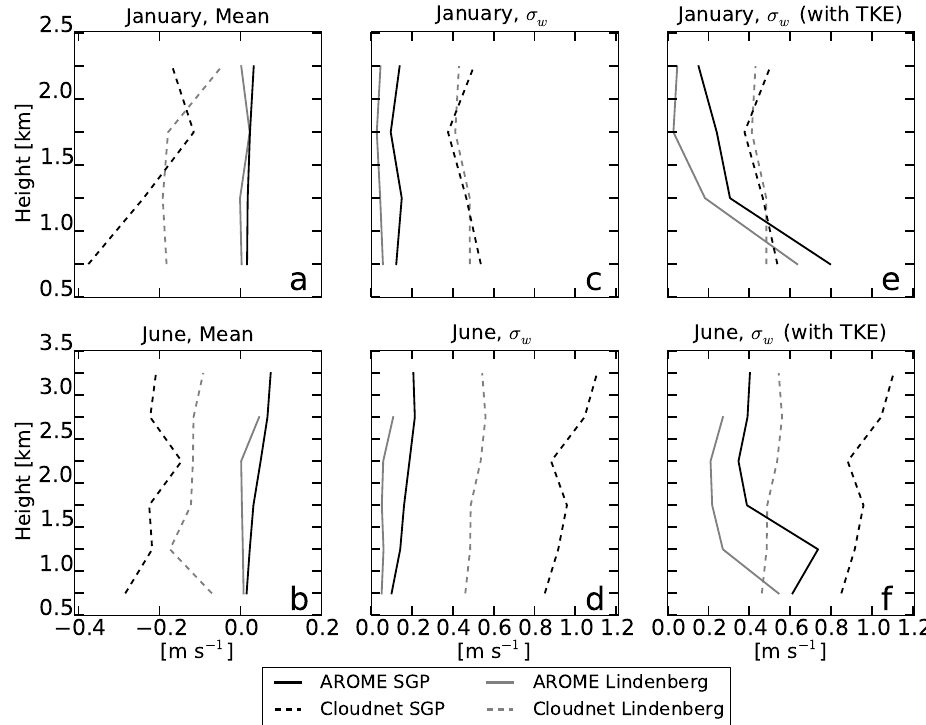
Fig. 5. Vertical velocity distribution statistics as a function of height at SGP (black) and Lindenberg (grey) for AROME (solid) and observations (dashed): (a, b) mean vertical velocity, (c, d) standard deviation ( σ w ), (e, f) σ w when a TKE-term has been added to the modelled vertical velocities (see